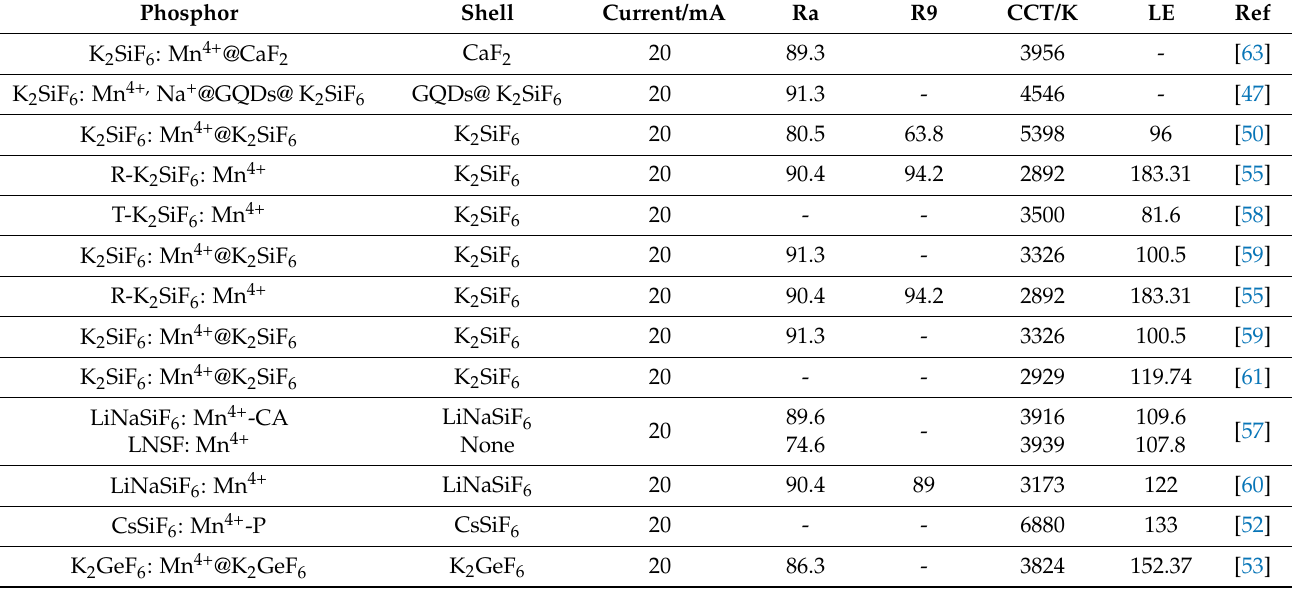
Table 2. Basic optoelectronic parameters of WLED devices encapsulated with A 2 MF 6 : Mn 4+ red